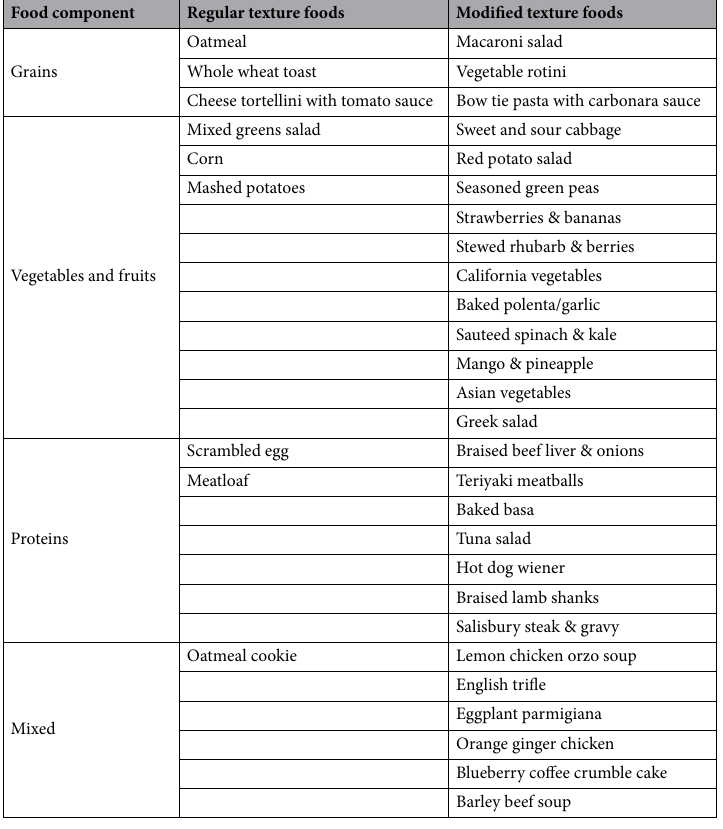
Table 1. Imaged foods represented in each of the regular texture foods dataset and the modified texture foods dataset. Regular texture foods were derived from LTC menus and imaged with three foods per meal (breakfast: oatmeal, toast, scrambled eggs; lunch: tortellini, salad, cookie; dinner: meatloaf, potatoes, corn) at every 25% incremental amounts of each food item relative to the full portion. Modified texture foods were imaged separately with at five incrementally smaller